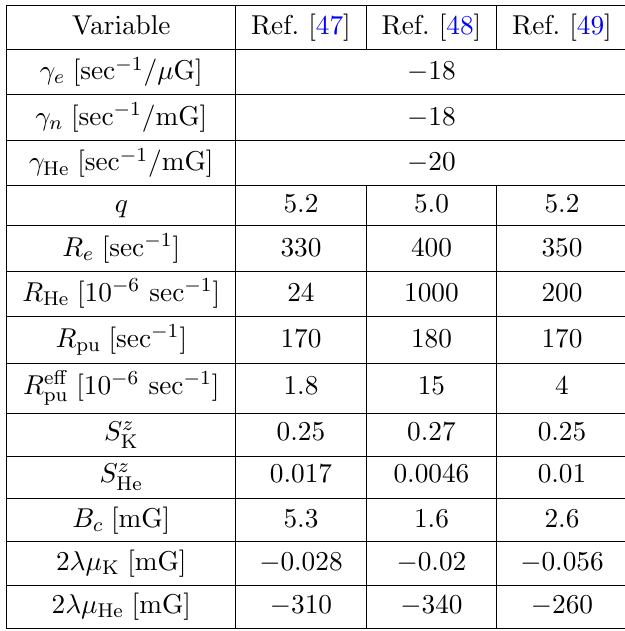
Table 1 . Values of important constants in eqs. (3.1){(3.2) (to two digits precision) from refs. [47{49]. As in ref. [48], we use directly measured values for observables, when